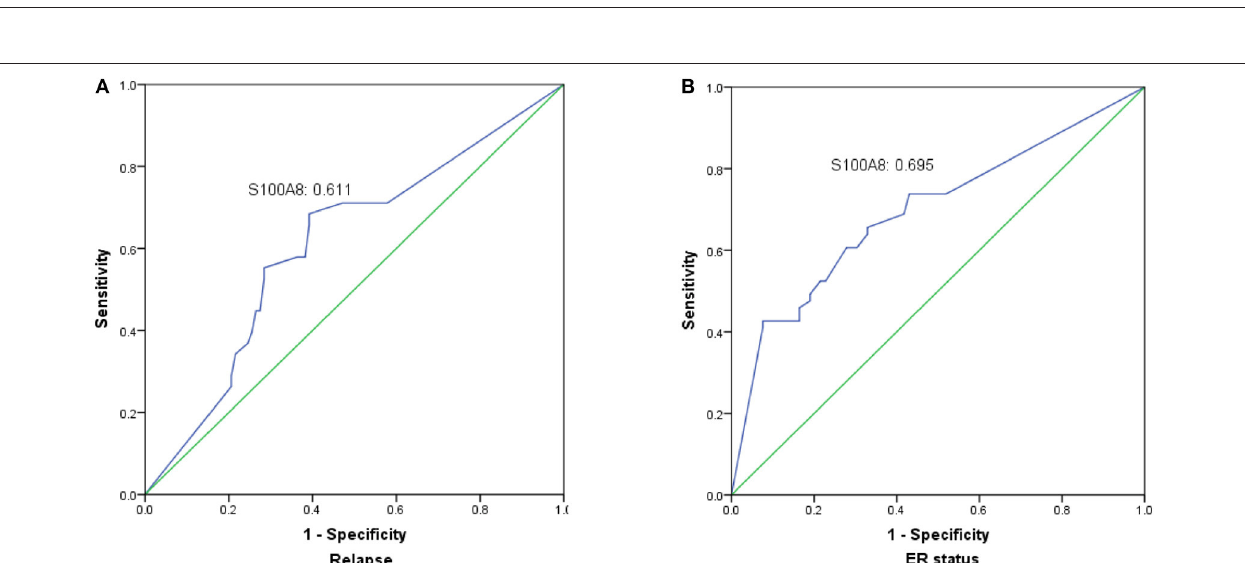
Frontiers in Oncology | www.frontiersin.org